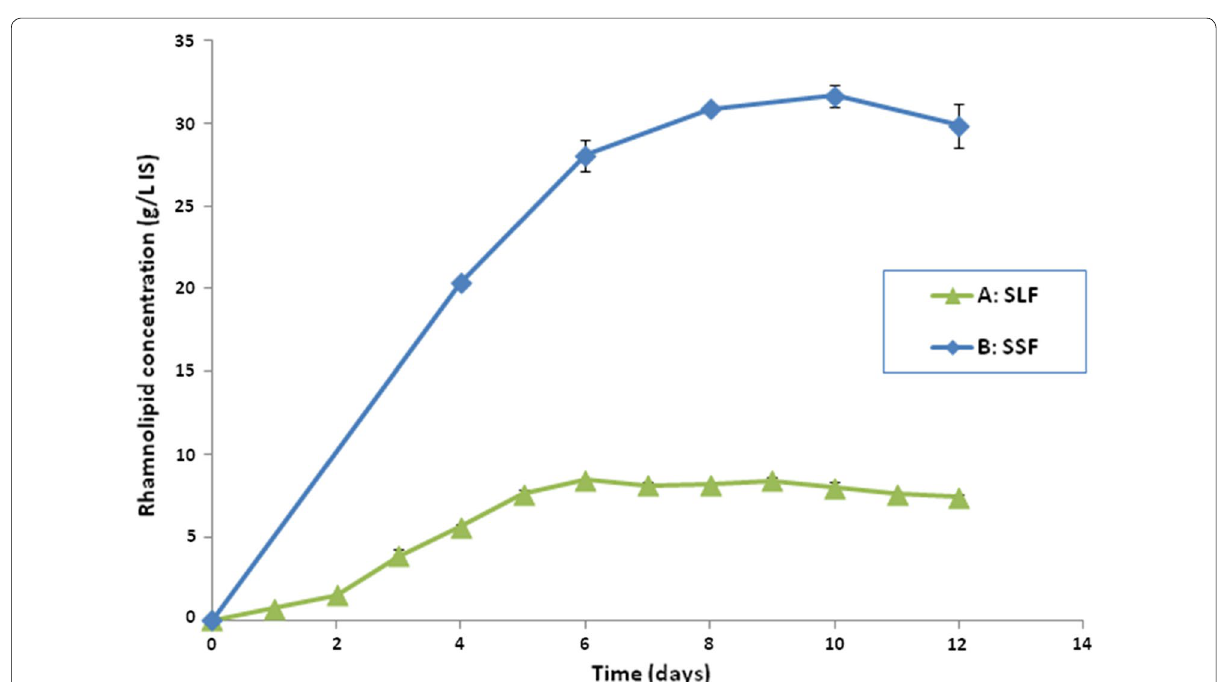
Fig. 2 Time course of RL production by P. aeruginosa 15GR in a SLF using GMSM culture media, 30 °C and 250 rpm; b SSF of a 50:50 mixture of sugarcane bagasse and sunflower seeds, using GMSM as an impregnating solution. Values plotted are the means of triplicate results while error bars indicate the standard deviation of the data